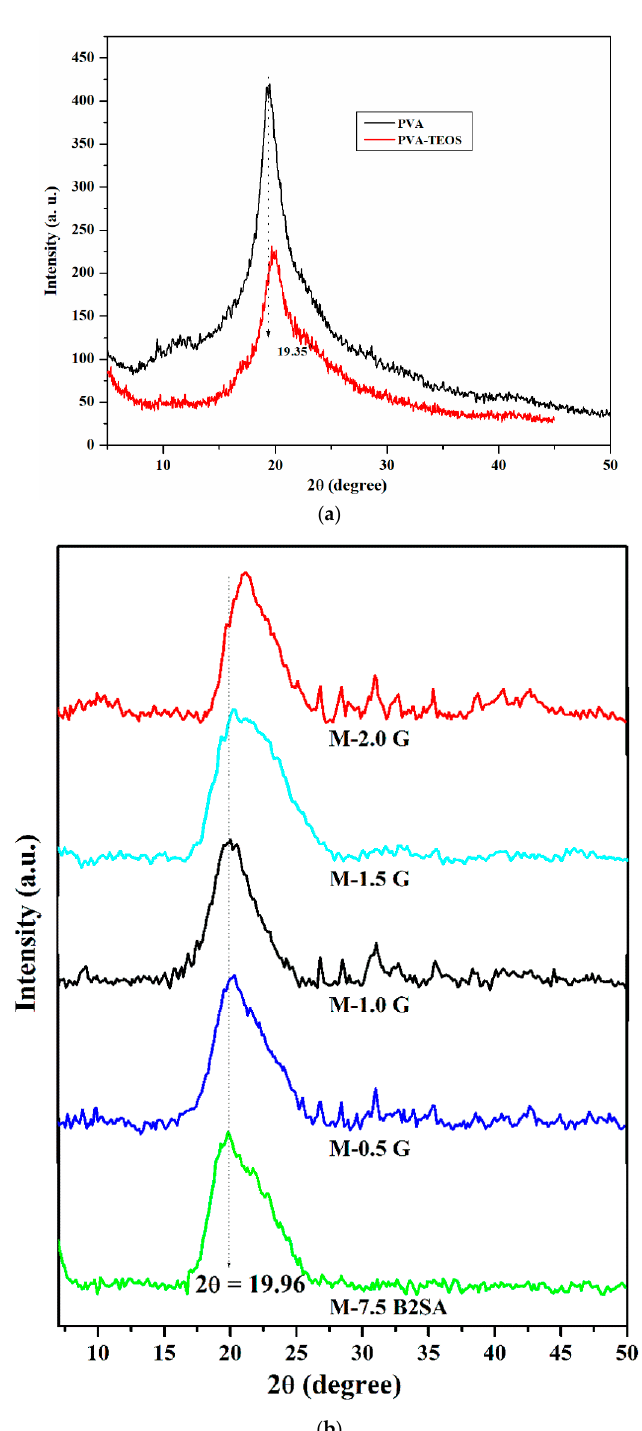
Figure 4. ( a ) Wide-angle X-ray diffraction patterns of plane PVA and PVA–TEOS membranes. ( b ) Wide-angle X-ray diffraction patterns of sulfonated PVA–TEOS (M-B2SA) and graphene-loaded sulfonated PVA–TEOS hybrid membranes: (M-0.5 G) 0.5 mass%; (M-1 G) 1 mass%; (M-1.5 G) 1.5 mass%; (M-2 G) 2 mass% of graphene.